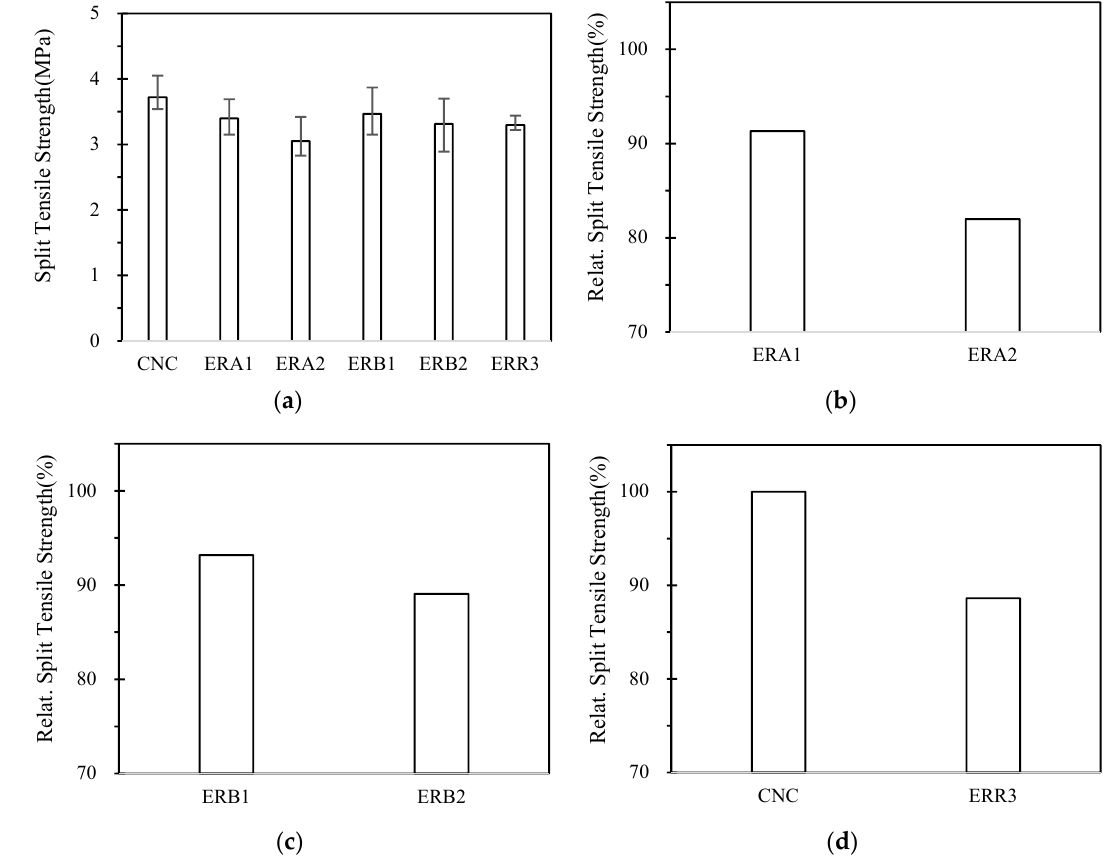
Figure 9. Split tensile strength results of concrete samples ( a ) strength, ( b ) relative value of ERA series, ( c ) relative value of ERB series, and ( d ) relative value of ERR mix.